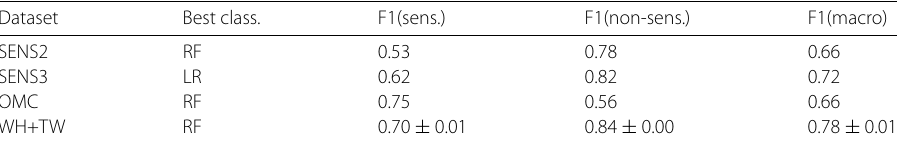
Results on WH+TW are averaged on ten samples Dataset Best class.